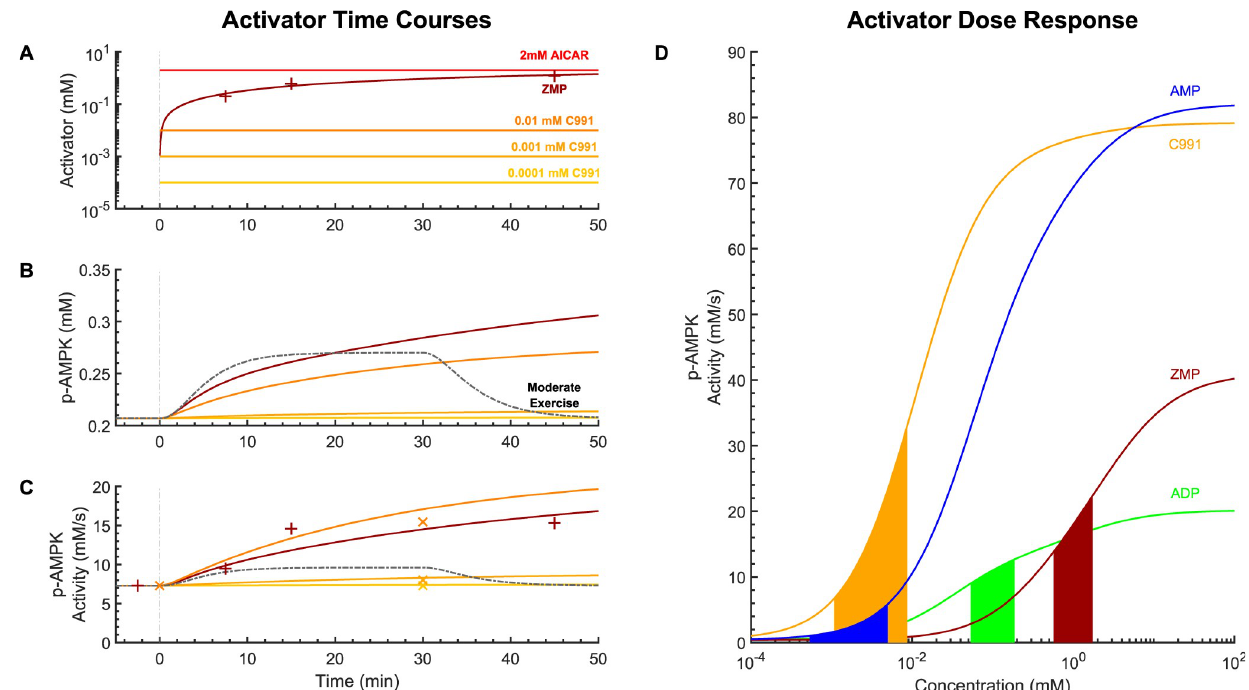
Fig 5. AMPK pharmacological activator analysis. Time courses and dose response of simulated AICAR perfusion, simulated Compound 991 incubation, ). A) Time courses of concentrations of activators. To simulate perfusion of AICAR, we assumed that its and moderate intensity exercise (63% _ V _ O 2 peak concentration remained unchanged throughout the simulation. The concentration of ZMP was fitted to published data. B) Time courses of phospho- AMPK (p-AMPK) concentrations for each simulation. C) Total AMPK activities for each simulation. The “ × ” and the “+” markers denote measured AMPK activities in response to Compound 991 and ZMP, respectively. D) Dose response of AMPK activities in response to treatment with Compound 991, ZMP, ADP, and AMP. The model was simulated independent of the bioenergetic module by removing reactions 1–5 and setting the AXP = 0 except if added exogenously, in which case its total concentration was held constant by setting generation and degradation reaction rates to zero. The reactions were simulated for 240 minutes and the steady-state values plotted. The filled portions under each curve indicate the ranges of activator concentrations that are either measured (AMP, ADP) or experimentally applied (ZMP, Compound